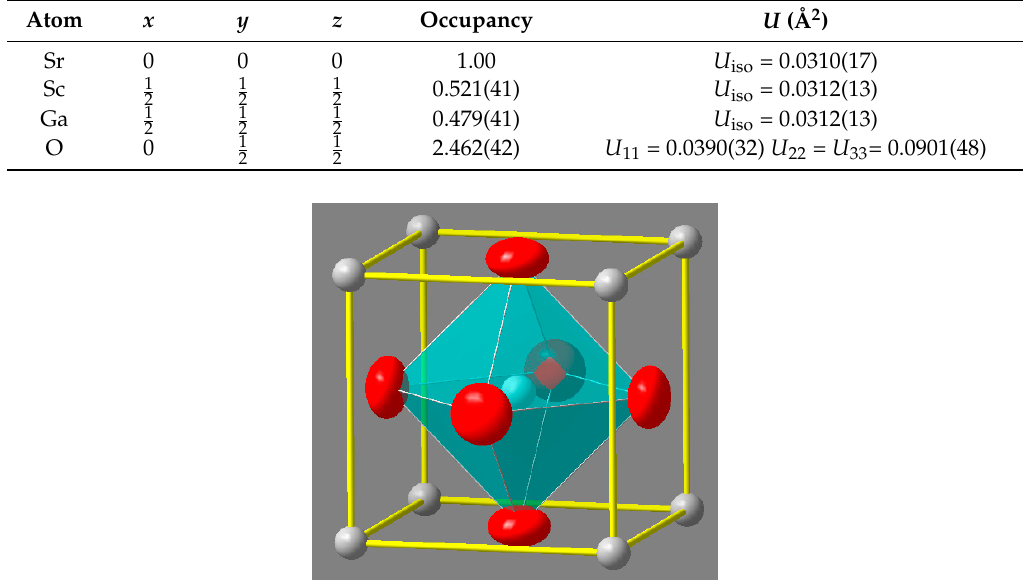
Figure 6. Oxygen-deficient cubic perovskite Sr 2 ScGaO 5 structure obtained at room temperature from neutron single crystal diffraction on 5C2 at the Laboratoire Léon Brillouin (LLB; Orphée reactor, France). While reasonable isotropic displacements are observed for Sr and (Sc/Ga), oxygen atoms show strong anisotropic displacement factors. Outlined are ellipsoids with 50% probability for all atoms.